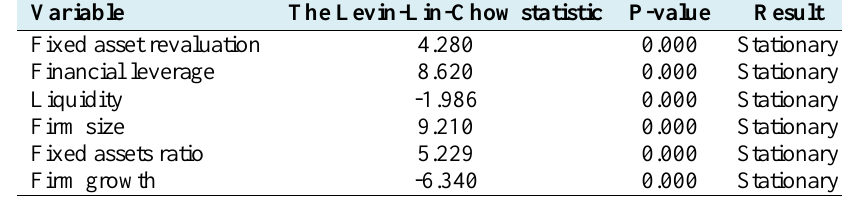
Table 14 . The results of testing the stationarity of research variables in the TSE